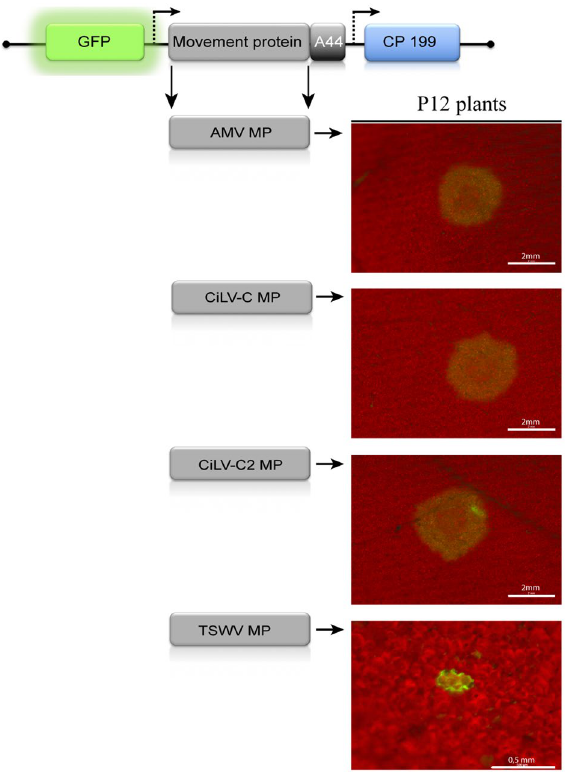
Figure 2. The cilevirus MP is able to transport infectious viral complexes. Analysis of cell-to-cell transport of the hybrid AMV RNA3, carrying different MP genes and the mutated coat protein gene (CP 199) defective in virus particles formation. The schematic representation corresponds to the same constructs indicated in Fig. 1A, in which the CP gene was replaced by the CP 199 gene from the construct pGFP/BMV:A44/CP199 9 by exchanging the Nhe I- Pst I fragment. P12 plants were inoculated with transcripts derived from the AMV RNA 3 variants expressing AMV wt (positive control), CiLV-C, CiLV-C2 and TSWV (negative control) MPs. The images of foci formation or single-cell GFP foci were observed at 2 days post-inoculation (dpi) using a Leica Stereoscopic Microscope. Each infection foci image is representative of the inoculation of three leaves per plant and three plants inoculated for each chimeric AMV construct. White bars represent 0.5 mm to 2